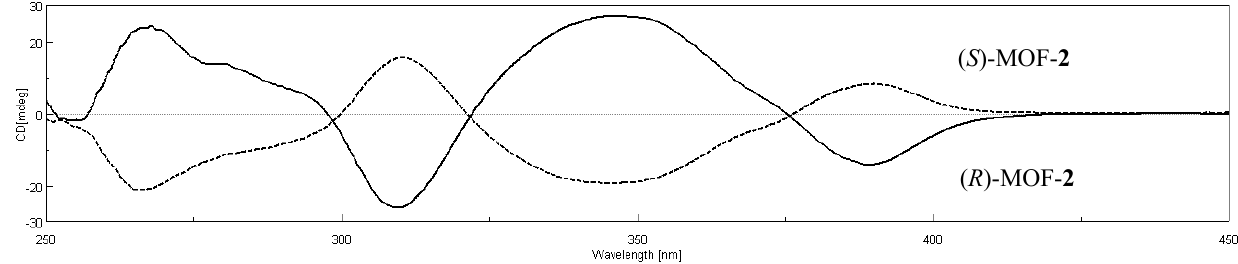
Figure 5. Solid-state CD spectra of ( R )- and ( S )-MOF -2 in KBr